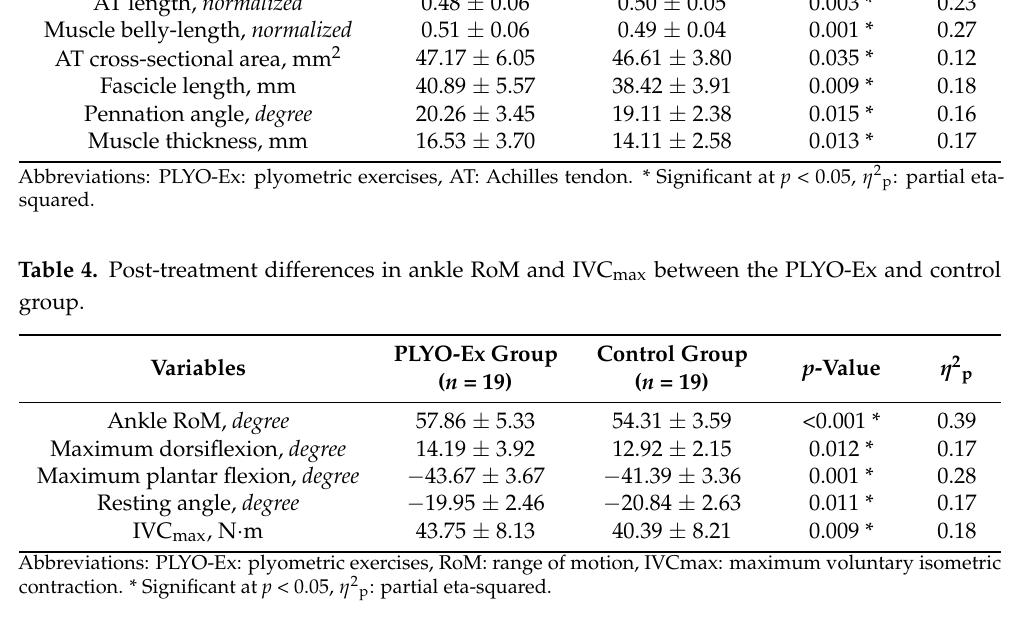
Table 3. Post-treatment differences in muscle-tendon morphological properties (normalized to length of the leg) between the study group. PLYO-Ex Group Variables ( n = 19) Muscle-tendon length, normalized